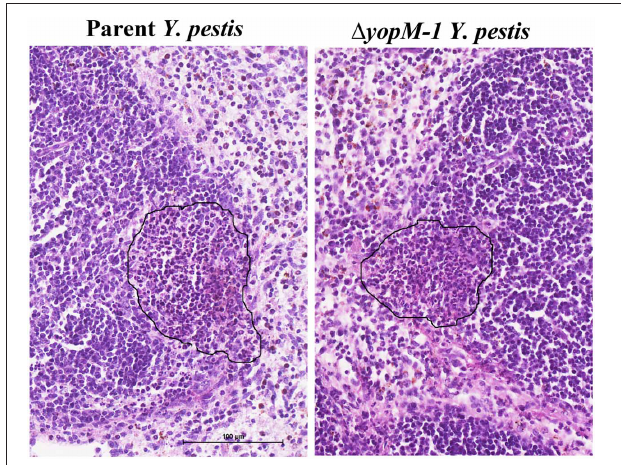
FIGURE 2 | Histopathology of spleen at 16h p.i. C57BL/6 mice were infected for 16h as in the experiments of Figure 1, and spleens were fixed in formalin and stained with hematoxylin and eosin. Representative sections are shown. Left panel, spleen from a mouse infected with parent Y. pestis ; Right panels, spleen from a mouse infected with (cid:2) yopM-1 Y. pestis . In each panel the surround indicates an inflammatory focus at the edge of a lymphoid follicle.